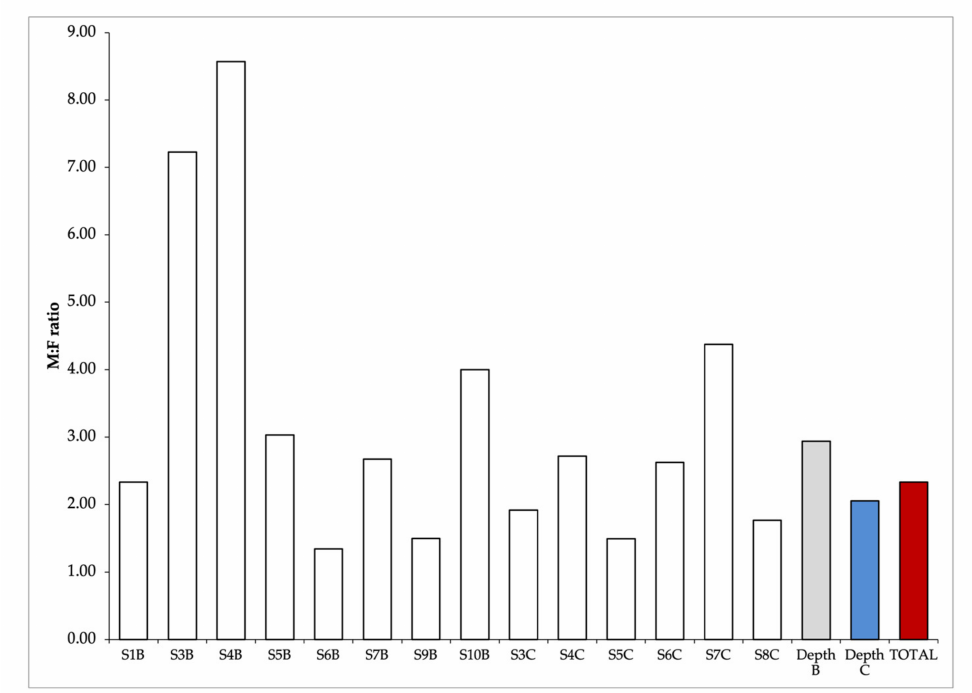
Figure 2. M:F ratio obtained by fishing quadrant, depth interval and total for Achelous spinicarpus . The correlation coefficients were statistically significant ( p < 0.001), while the growth rate obtained through the CW and W ratios were negative allometric for both sexes and overall, with significant differences in the slopes between both sexes ( t (0.05; g.l. = 2375) = 1.96, p < 0.05) (Table 2; Figure 3). Table 2. Parameters of the relationship between carapace width (CW) and weight (W) for Achelous spinicarpus , overall and by sex, number of crabs ( n ), ordinate to the origin (a), slope (b), standard error of slope (SE) and correlation coefficient (R 2 ).